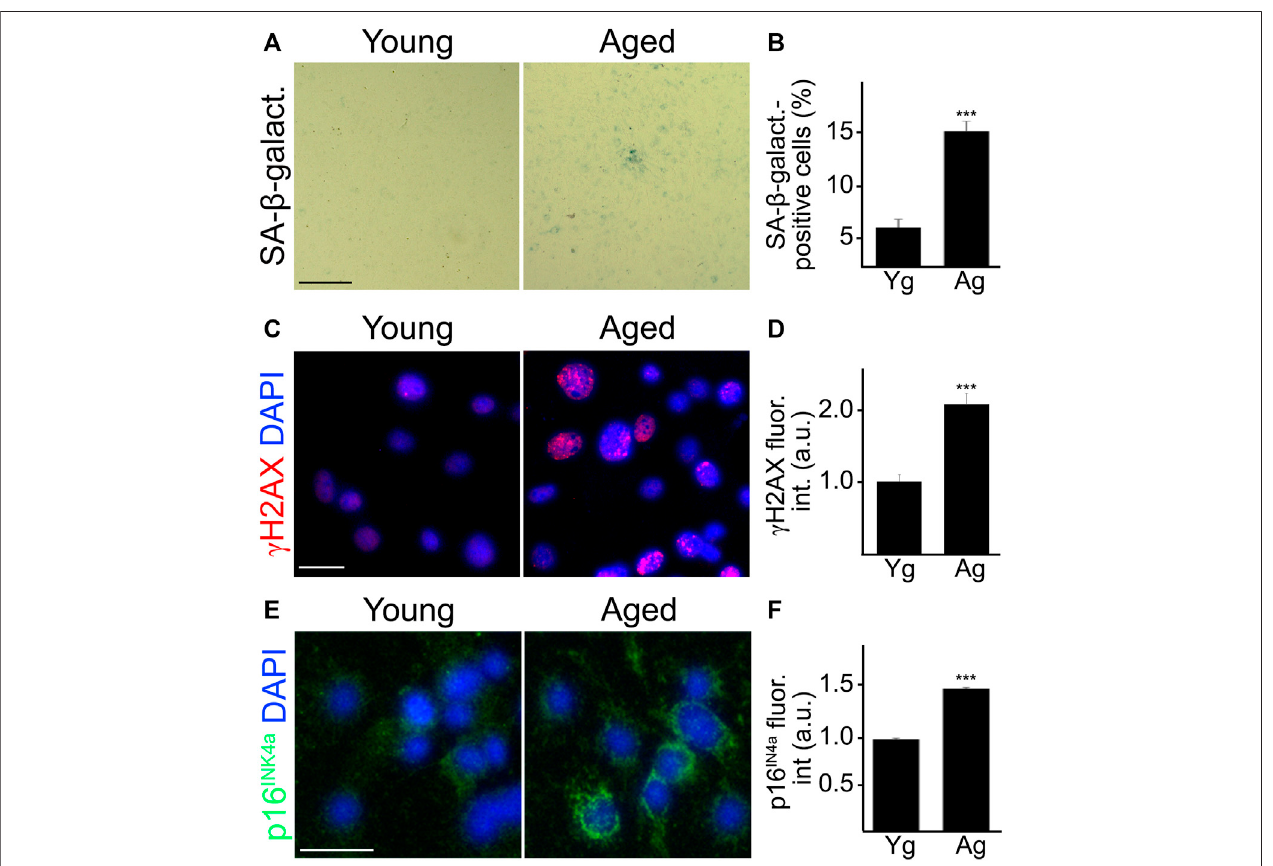
FIGURE 1 | Cultured primary CEC from aged mice recapitulated senescence-associated phenotypes observed in vivo . CEC were isolated from young (3 – 4 m/o) andaged(18 – 20 m/o)femalemiceandcultured.YoungandagedculturedCECwerestainedforSA- β -galactosidase (A) ,withantibodiesagainstthedouble-strandDNA damage marker γ H2AX (C) , or with antibodies against the tumor suppressor p16 INK4A (E) . The nuclear Hoechst dye was used to stain nuclei and imaged with the DAPI channel (C , E) .Thepercentage ofSA- β -galactosidase-positivecells (B) ,the fl uorescenceintensityof γ H2AX (D) andthe fl uorescenceintensityofp16 INK4A (F) were quanti fi ed. Scale bar (A) , 100 μ m; scale bar (C) , 25 μ m; scale bar (E) , 25 μ m. t -test, *** p -value < 0.0001. Data were pooled from three independent experiments, 20 microscopic fi elds (A , B) , or 50 cells (C – F) per each experiment and